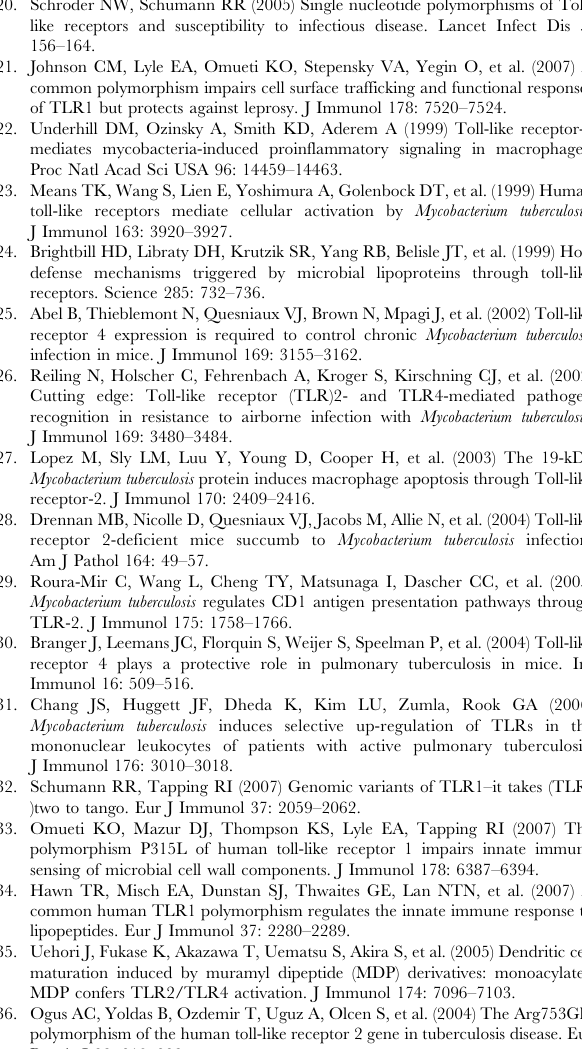
Table S1 Genetic variants in human TLR1, 2, 4, 6, 10 genes Found at: doi:10.1371/journal.pone.0001318.s002 (0.10 MB Table S2 Associations between common nonsynonymous vari- ants of TLR1, 4, 6, 10 genes with TB and Extrapulmonary TB (EPTB) disease